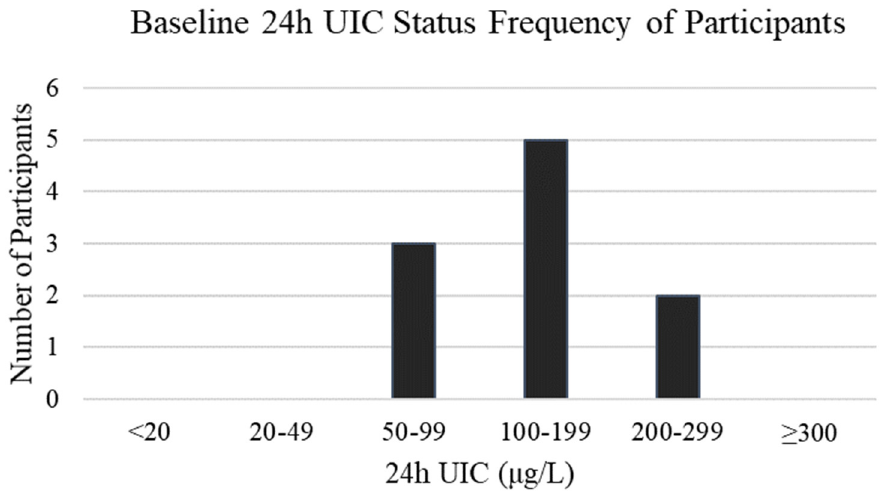
Figure 2. Iodine status based on the World Health Organization (WHO) criteria for urinary iodine concentration (UIC) [13]: <20 μ g/L (Severe Deficiency); 20–49 μ g/L (Moderate Deficiency); 50–99 μ g/L (Mild Deficiency); 100 199 μ g/L (Adequate); 200–299 μ g/L (Above Adequate); ≥ 300 μ g/L (Ex-